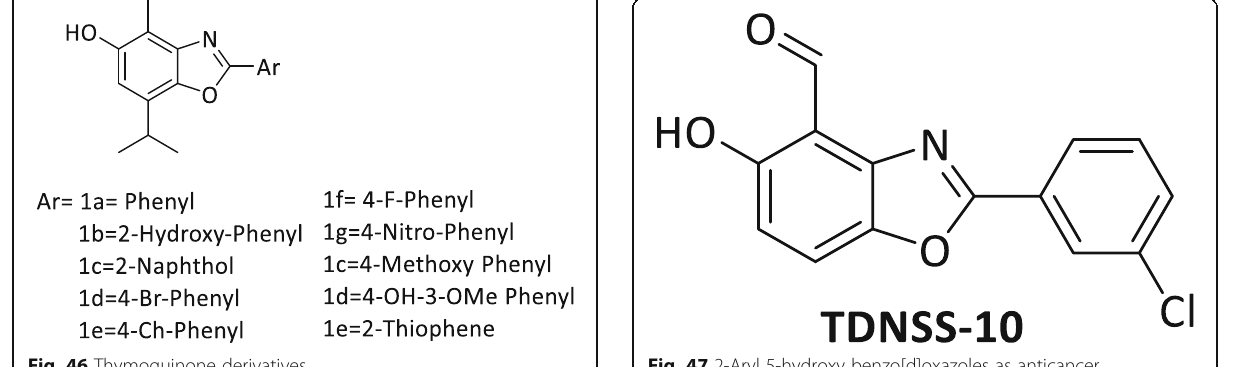
Fig. 46 Thymoquinone derivatives Fig. 47 2-Aryl 5-hydroxy benzo[d]oxazoles as